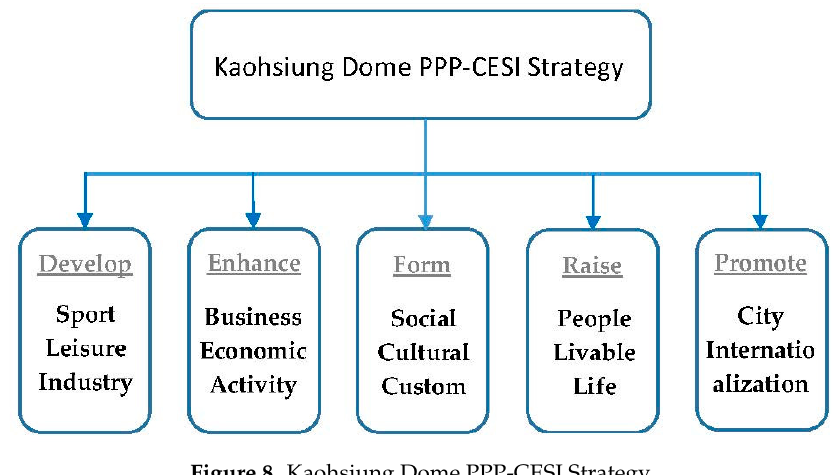
Figure 8. Kaohsiung Dome PPP-CESI Strategy.